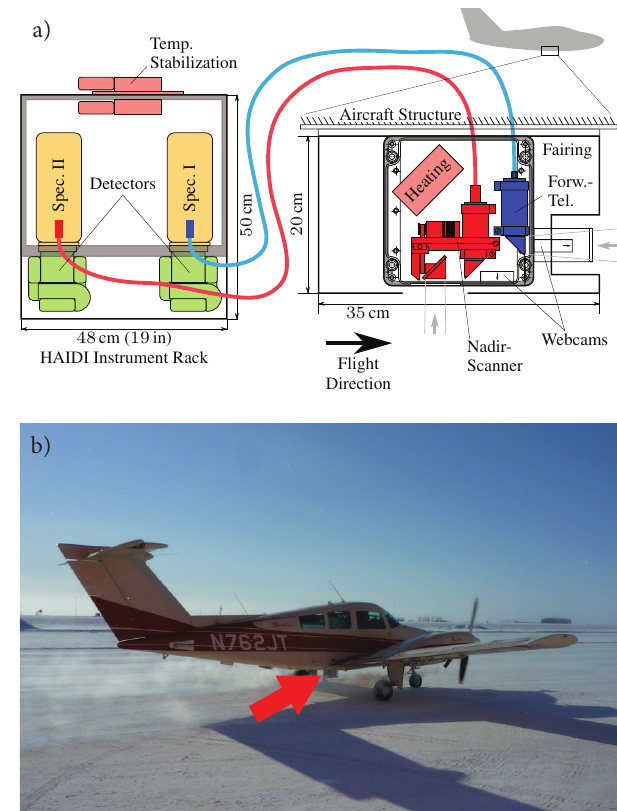
Figure 16. Installation of HAIDI on an ultralight aircraft during the measurements on Sicily, Italy. (a) top view sketch of the CTLS baggage compartment with HAIDI installed. The entrance optics of the instrument are located outside the aircraft. While the nadir scanner (red) is placed close to the aircraft fuselage, the forward- looking telescope (blue) is mounted to an extension arm to get a free line of sight. (b) Picture of the CTLS showing the location of the entrance optics (red arrow).